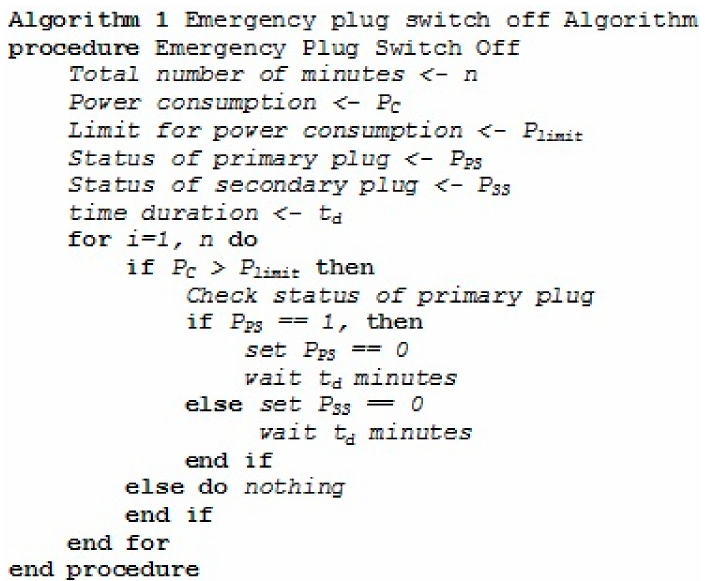
Figure 8. Algorithm followed for the emergency plug switch